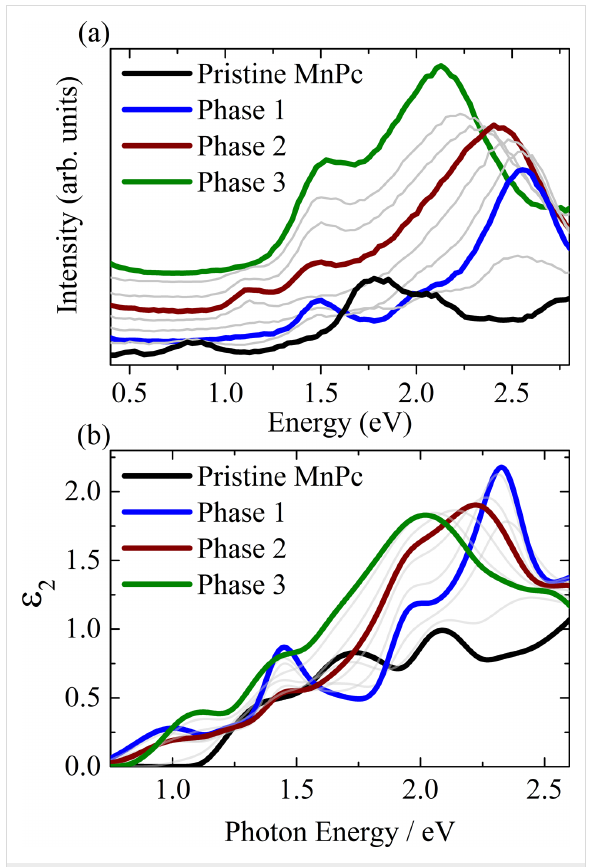
Figure 2: Evolution of the electronic-excitation spectra of MnPc upon potassium doping as determined using electron energy-loss spectros- copy (panel (a)) and spectroscopic ellipsometry (panel (b)). Panel (a) shows the so-called loss function, Im( − 1/ ε ) [56], while panel (b) shows the imaginary part of the dielectric function, ε 2 [49]. The potassium concentration increases from MnPc over phase 1 to phase 2 and 3. Thicker lines depict the spectra for particular doped phases as de- scribed in the